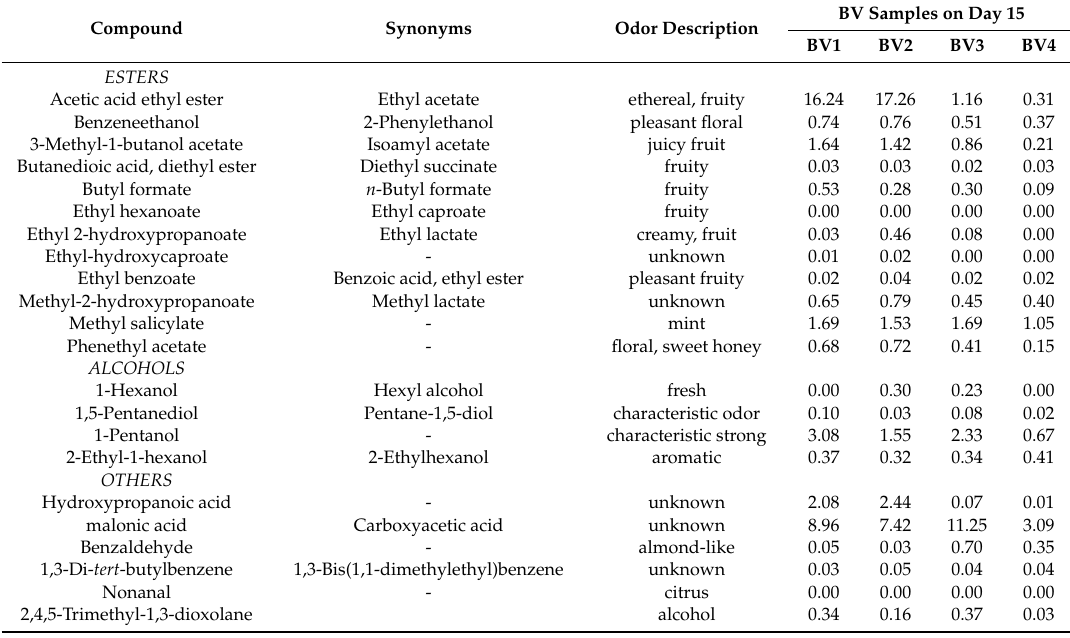
Table 2. Odor description of volatiles found in bellflower vinegar (BV) samples by gas chromatography–mass spectrometry